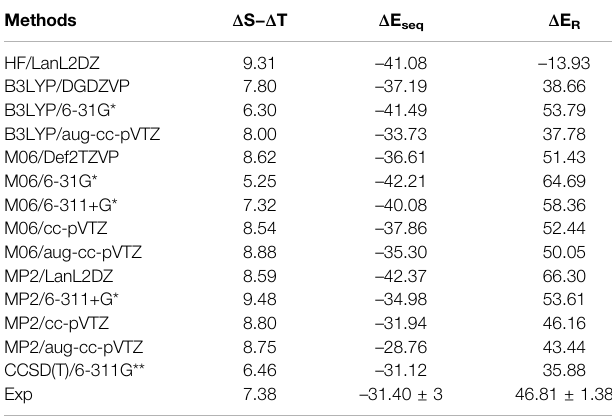
TABLE 1 | Reaction energy ( Δ E R ) for the reaction Sc + + OH 2 → Sc + O+ H 2 + Δ E, sequential binding energy ( Δ E seq ) of ground-state Sc + OH 2 complex, and Δ S − Δ T for the bare Sc + ion. All values are reported in kcal/mol.